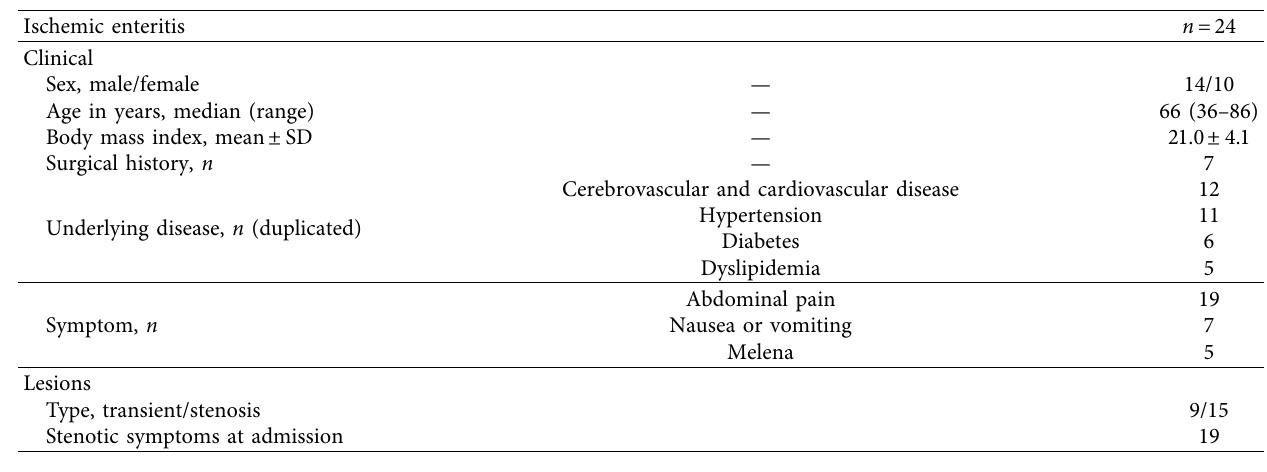
Table 2: Patient characteristics.